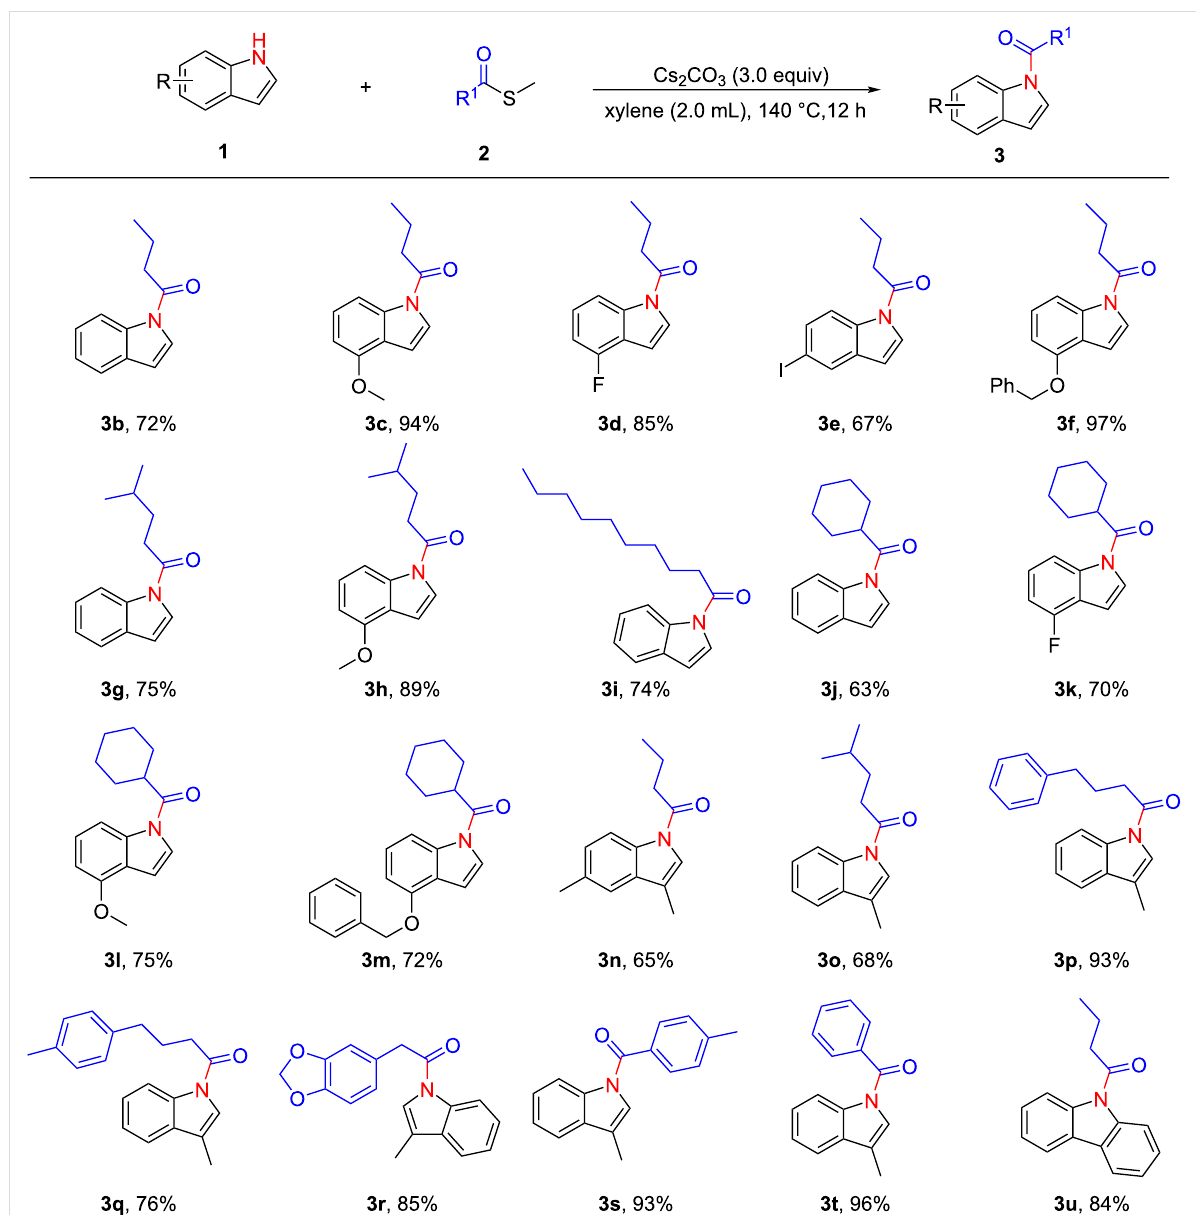
Scheme 2: Reactions of thioesters and indoles. Reaction conditions: 1 (0.2 mmol, 1.0 equiv), 2 (0.6 mmol, 3.0 equiv), Cs 2 CO 3 (0.6 mmol, 3.0 equiv), xylene (2.0 mL), 140 °C, 12 h. Isolated yields are shown.